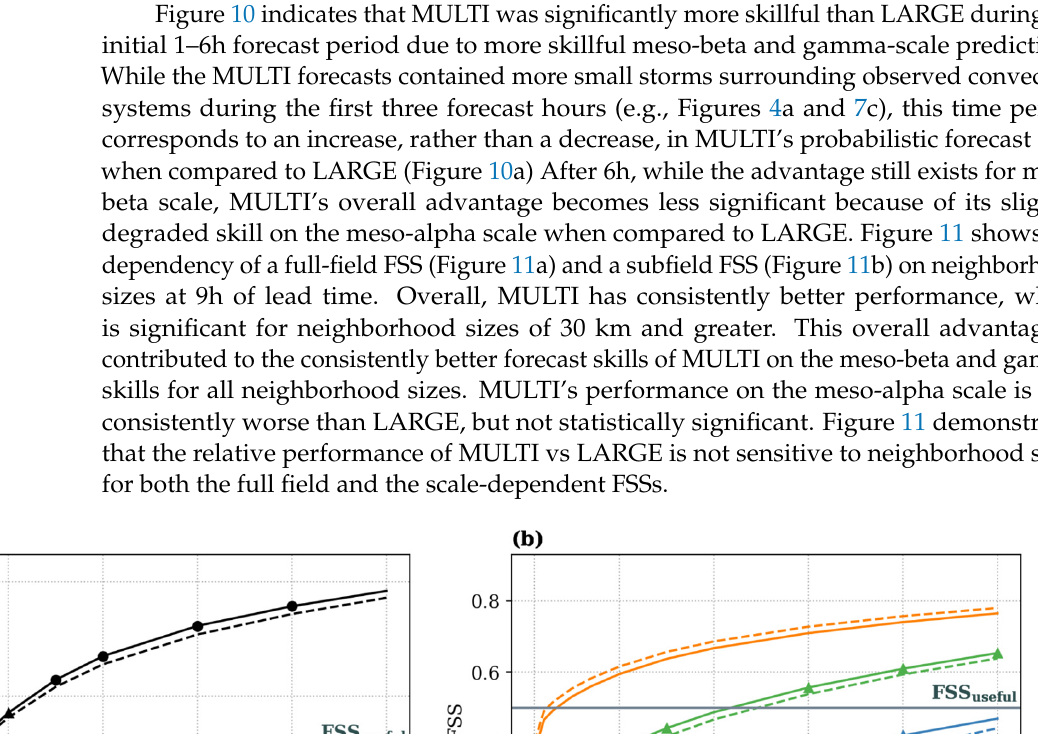
Figure 10. MULTI and LARGE FSSs for NMEPs derived with a 35 dBZ threshold and a 9 km neighborhood size for ( a ) the full field, ( b ) meso-alpha, meso-beta, and meso-gamma subfields aggregated over 25 cases. Dots along the FSS curves indicate statistically significant differences determined by Wilcoxon rank sum test, with filled (open) dots representing improved (degraded) skill for MULTI at the 10% confidence level.